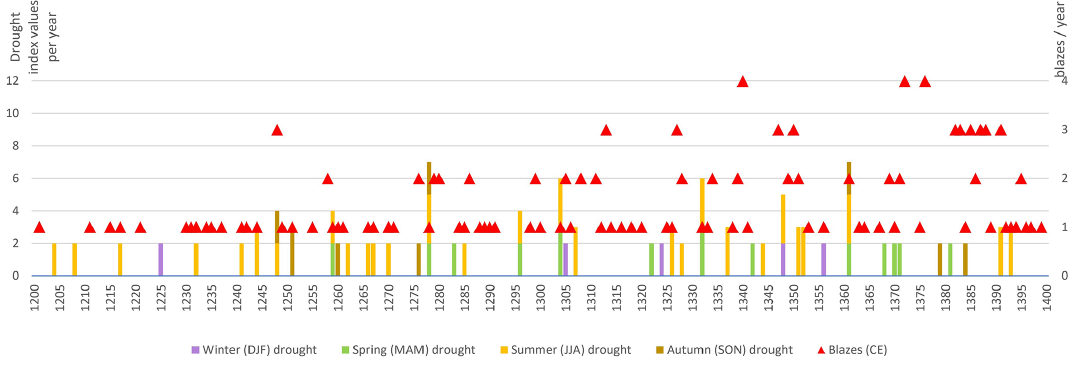
Figure 10. Reconstruction of drought indices compared with a chronology of fires for CE, 1200–1400. Data are available for 125 years out of 200 (62.5% coverage).